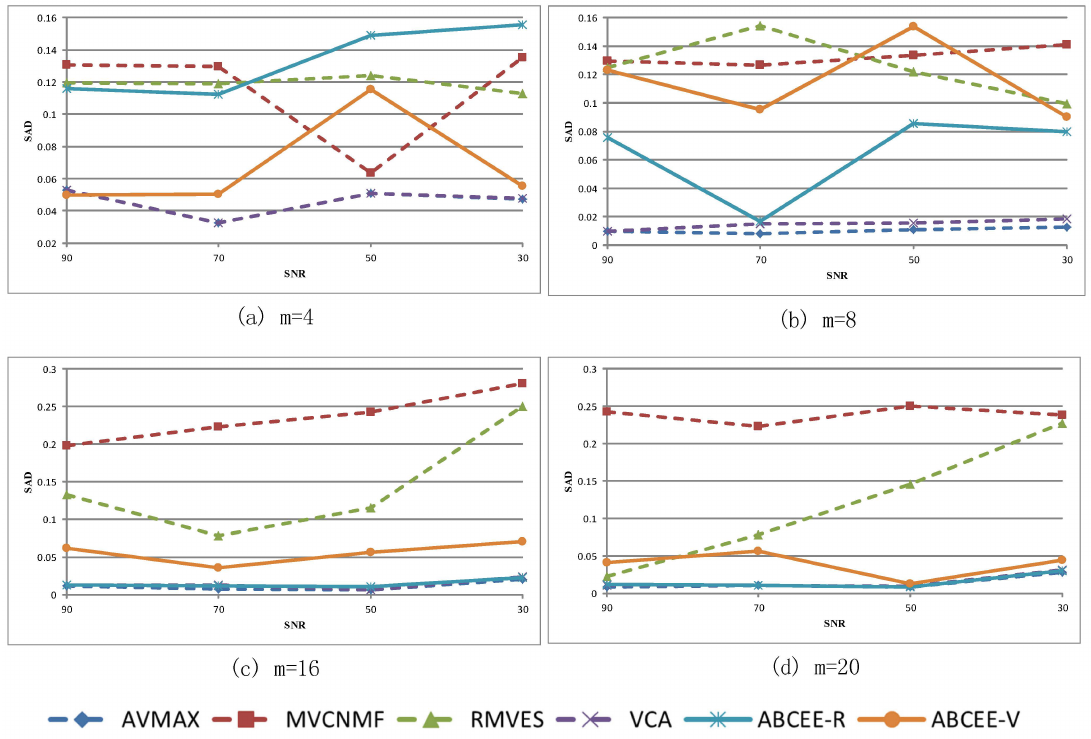
Figure 6. SADs for synthetic Dataset 2. ( a ) m=4; ( b ) m=8; ( c ) m=16; ( d )